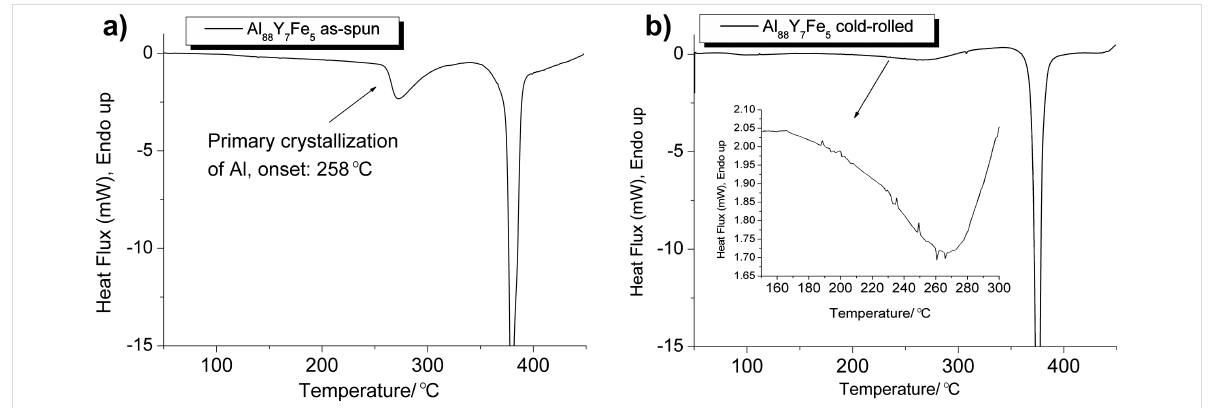
Figure 4: (a) DSC trace for an as-spun Al 88 Y 7 Fe 5 ribbon sample. (b) DSC trace for the cold-rolled Al 88 Y 7 Fe 5 ribbon sample. The inset shows the pri- mary crystallization range after cold rolling. The heating rate was 20 K/min for both measurements.